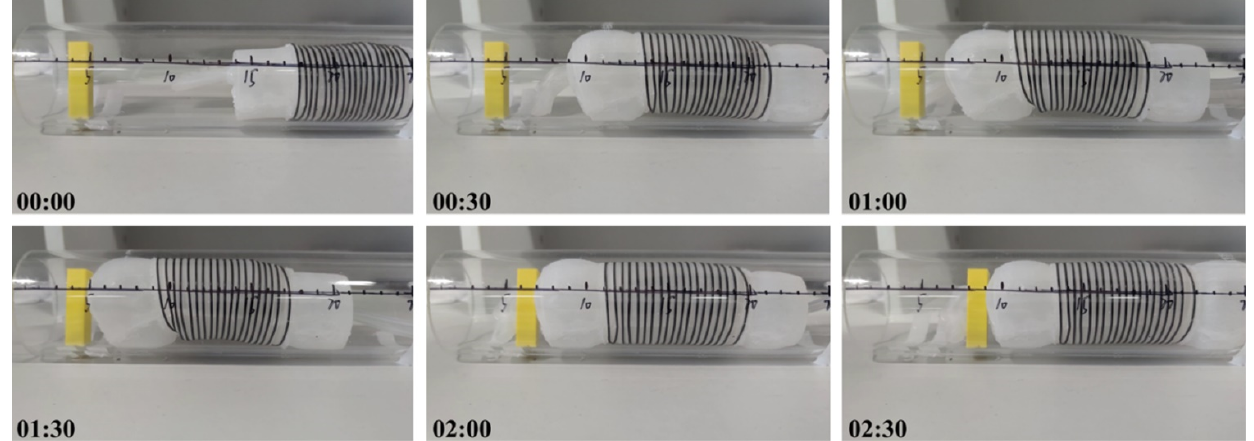
Figure 6. The intestinal soft robot performs moving and extracting tasks in a transparent rigid tube. (The number represents the running time of the soft